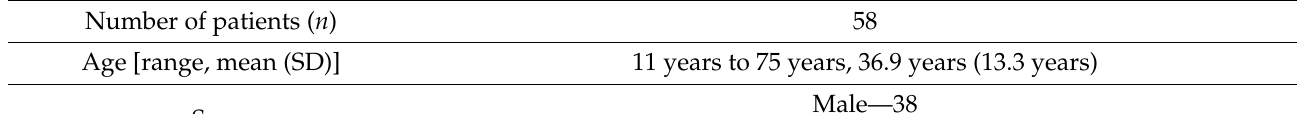
Table 1. Characteristics of study